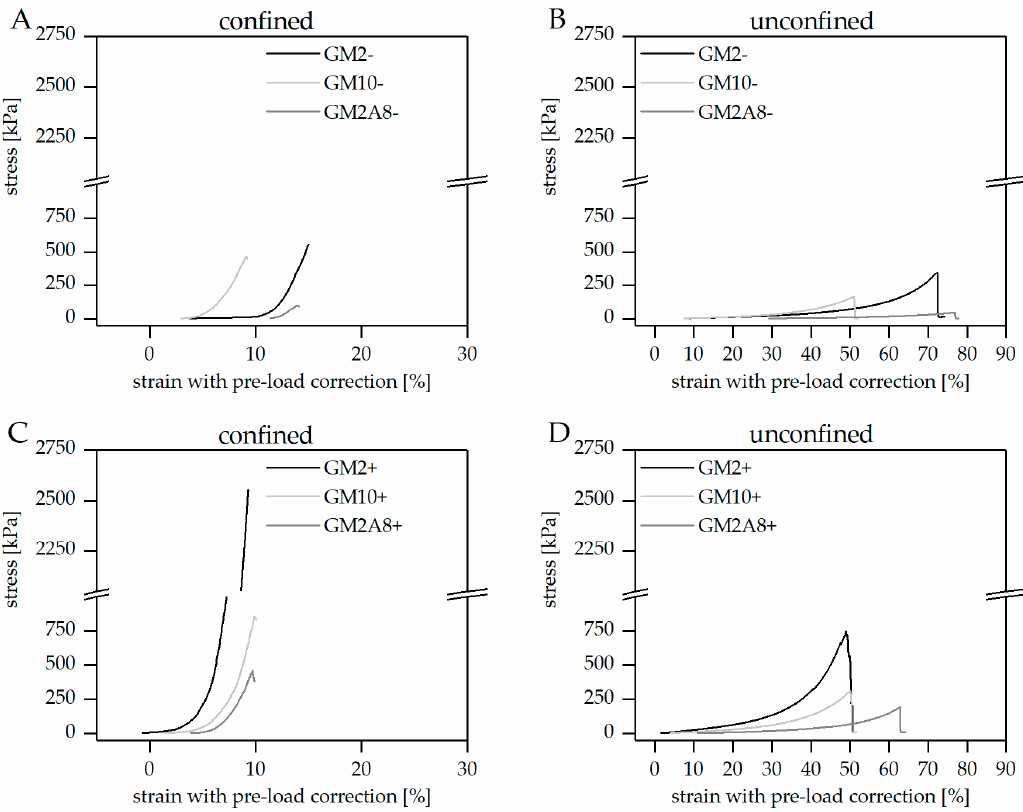
Figure 2. Stress-strain diagrams of gelatin methacryloyl acetyl (GM(A)) hydrogels made without ( − ) ( A,B ) and with cooling (+) ( C,D ) prior to chemical cross-linking and measured in confined ( A,C ) and unconfined ( B,D ) set-up. The utilized pre-load of 0.2 N deformed the gels to different extents; therefore we determined the respective deformation and added it to the measured strains, which shifted the curves to the right to the corrected, effectively applied overall strains, resulting in different initial strains for the various specimens. Material failure resulted in complete drop of stress in the unconfined set-up ( B,D ). In the confined set-up the first drop of stress was interpreted to indicate material failure and curves are only displayed up to the corresponding strain ( A,C ).